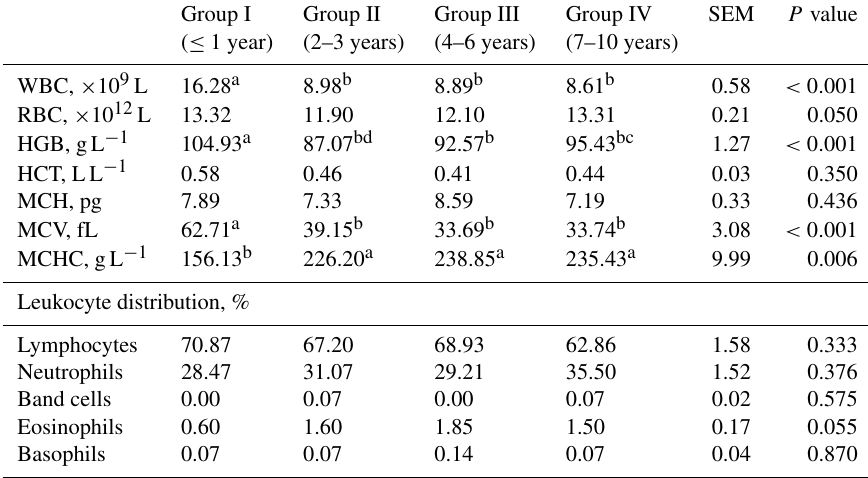
Table 2. Haematological parameters and leukocyte distribution from goats of different ages.